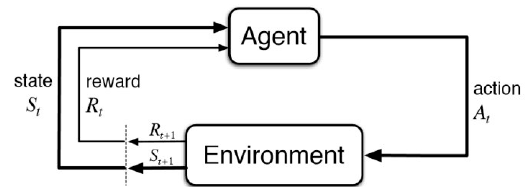
Figure 2. Basic idea and elements involved in a reinforcement learning formalization.